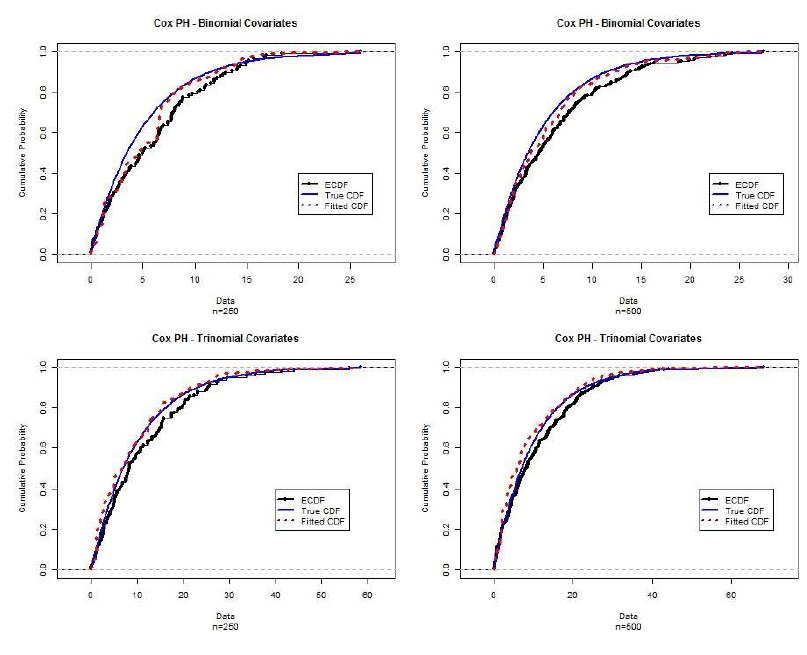
Figure 1 – Cox PH model, with Discrete Covariates